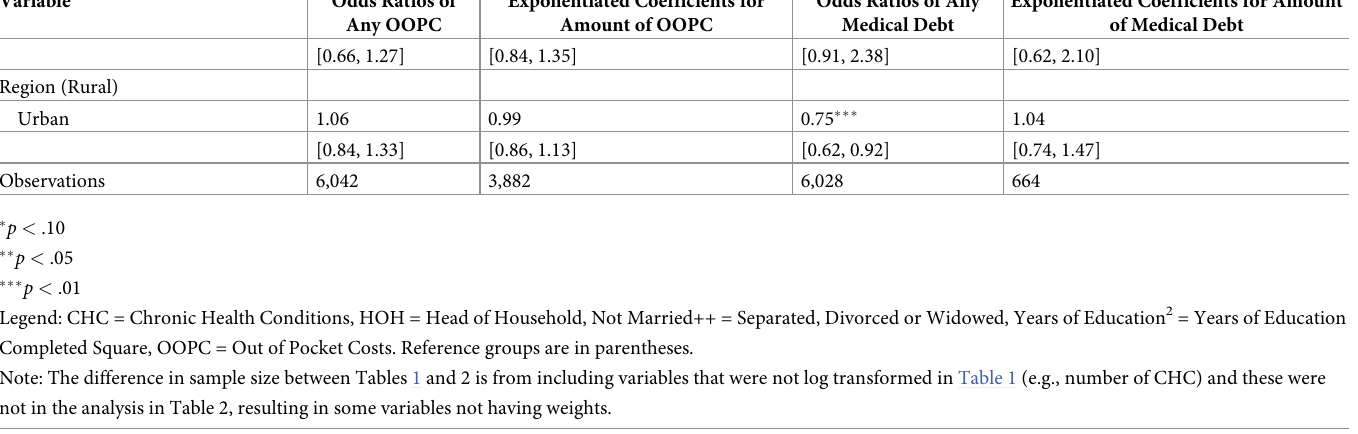
were associated with higher amounts of OOPC (Exponentiated Coefficient 1.18, 95% CI 1.03 to 1.36; Exponentiated Coefficient 1.56, 95% CI 1.17 to 2.07) and the amount of medical debt (Exponentiated Coefficient 1.69, 95% CI 1.23 to 2.34; Exponentiated Coefficient 2.73, 95% CI 1.19 to 6.25) compared to households with no chronic conditions ( p < 0.05). These